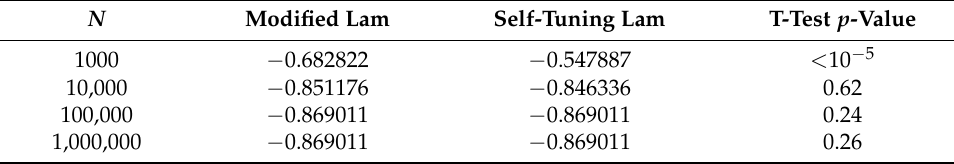
Table 15. Average solution for minimizing g 1 ( x ) . The minimum is g 1 ( x ) ≈ − 0.869011. N